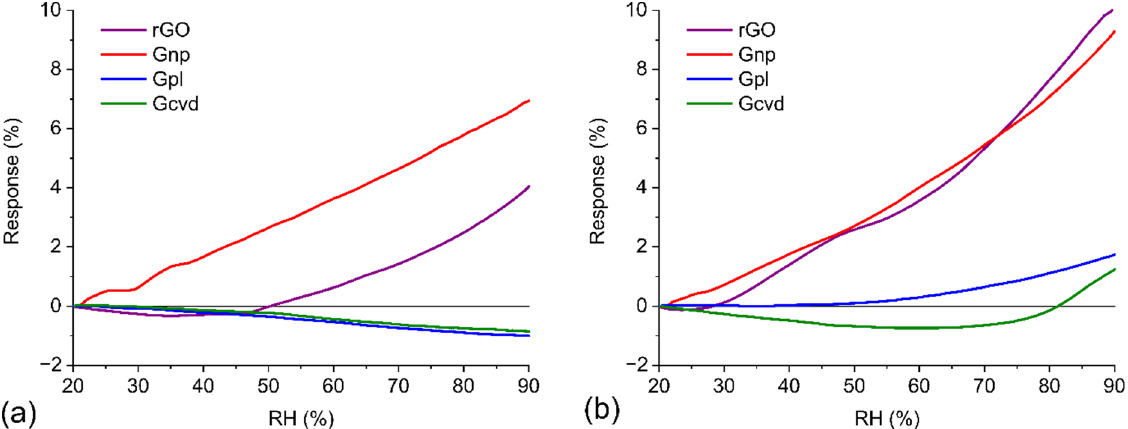
Figure 7. Humidity dependences of graphene-based materials ( a ) at 20 °C during the RH test and ( b ) at 50 °C during the RH test.